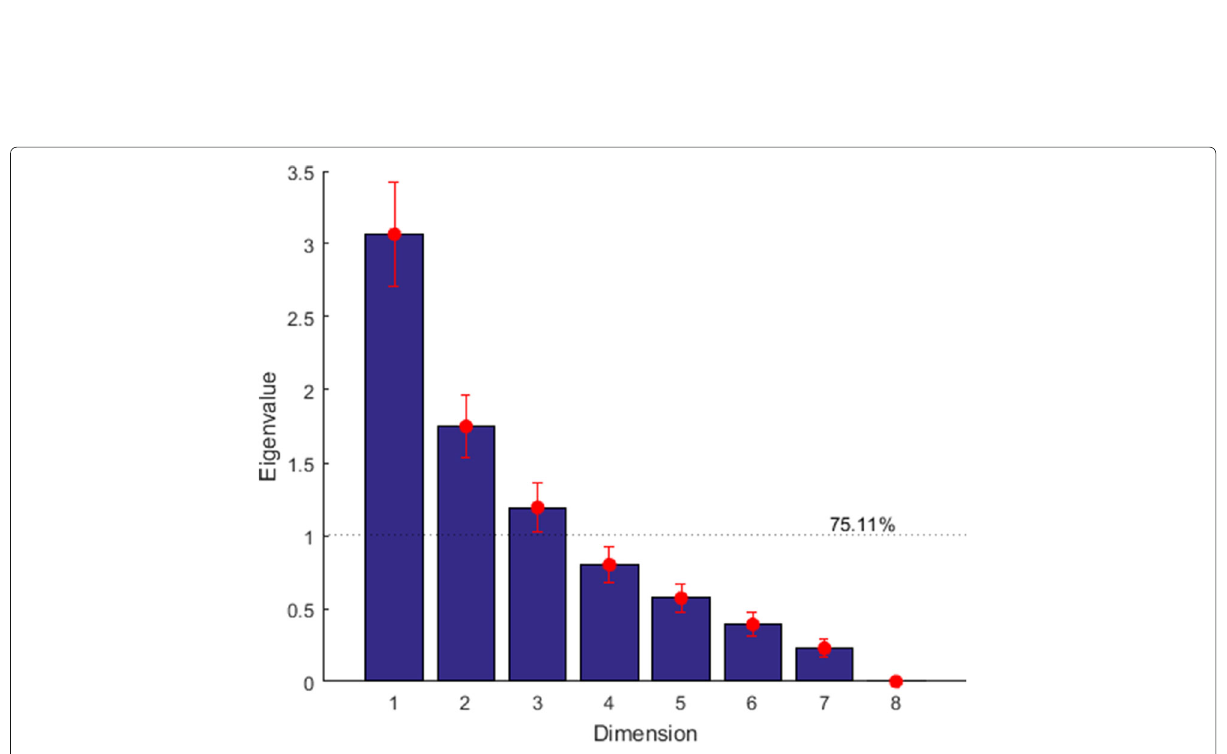
Fig. 9 Scree plot showing eigenvalues of the decomposition of the 8-dimensional partitioned dataset for the common characteristics. The dotted line shows the Kaiser-Guttman reference line for eigenvalues>1, indicating that at least three of the eight dimensions are relevant. These account for 75.11% of the total variance in the 8-dimensional dataset. Error bars show standard errors for 1000 bootstrap replicates of the CA